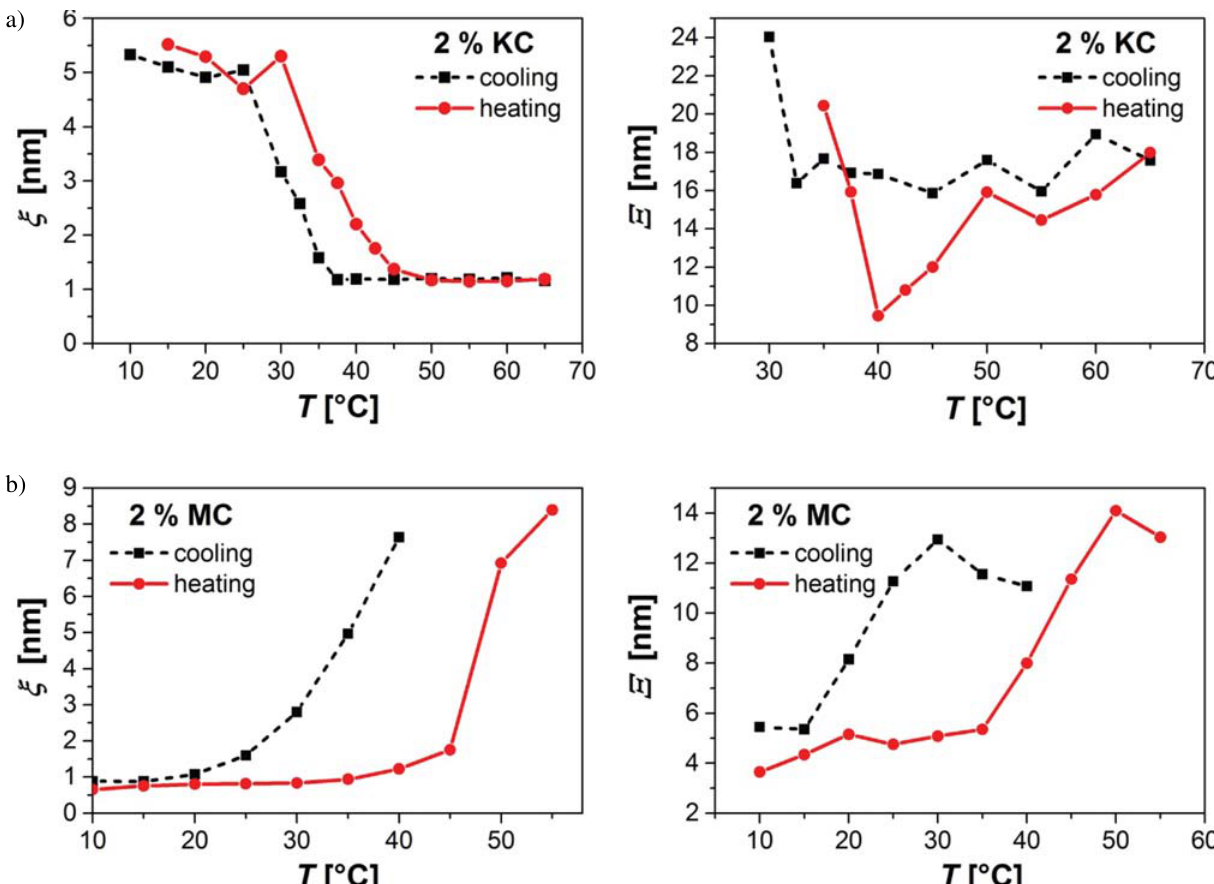
Figure 5. Thermally induced change of the dynamic and static correlation lengths ξ and Ξ in 2 wt. % (a) KC and (b) MC system. The results are shown only for the temperature regime where Equation (11) performs